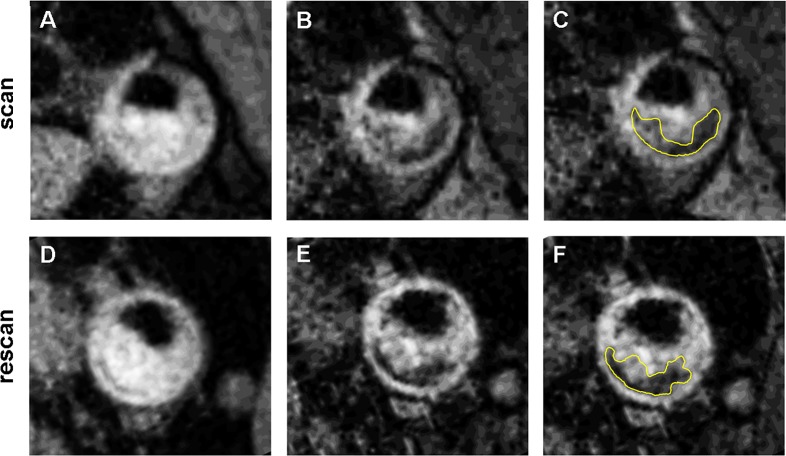
Representative sample of scan and rescan HR images containing a LRNC.Panel A and B show the difference in intensity between a T1w (panel A, panel D) and a T2w (panel B, panel E) image for the LRNC of a scan and rescan respectively. Panel C (scan) and panel F (rescan) show the manual delineation of the LRNC with the closed segmentation method.